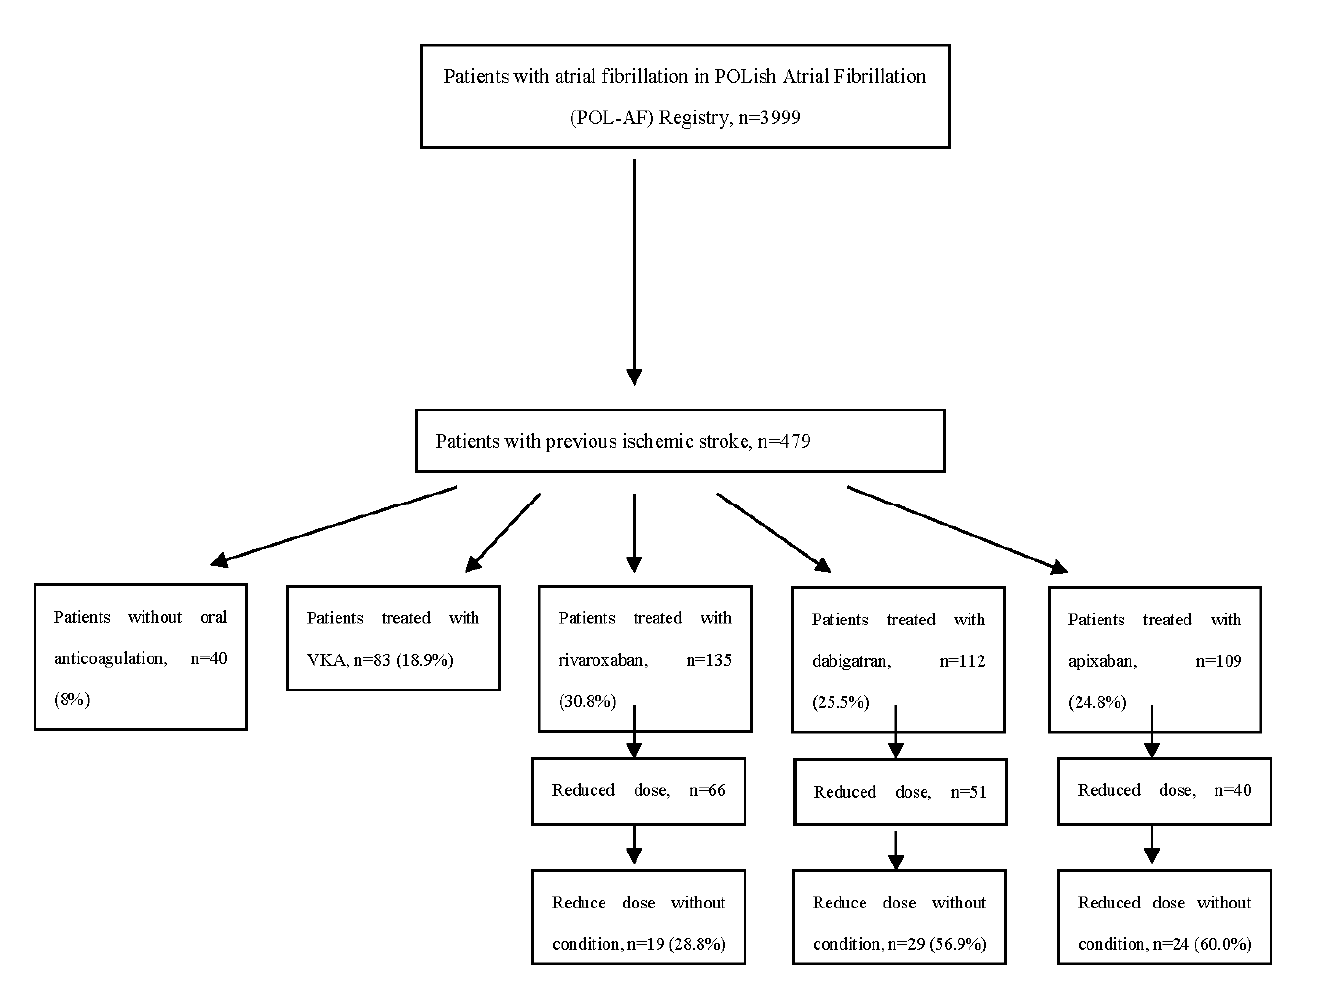
Figure 1. The flow chart of the study. Abbreviations: VKA, vitamin K antagonist.